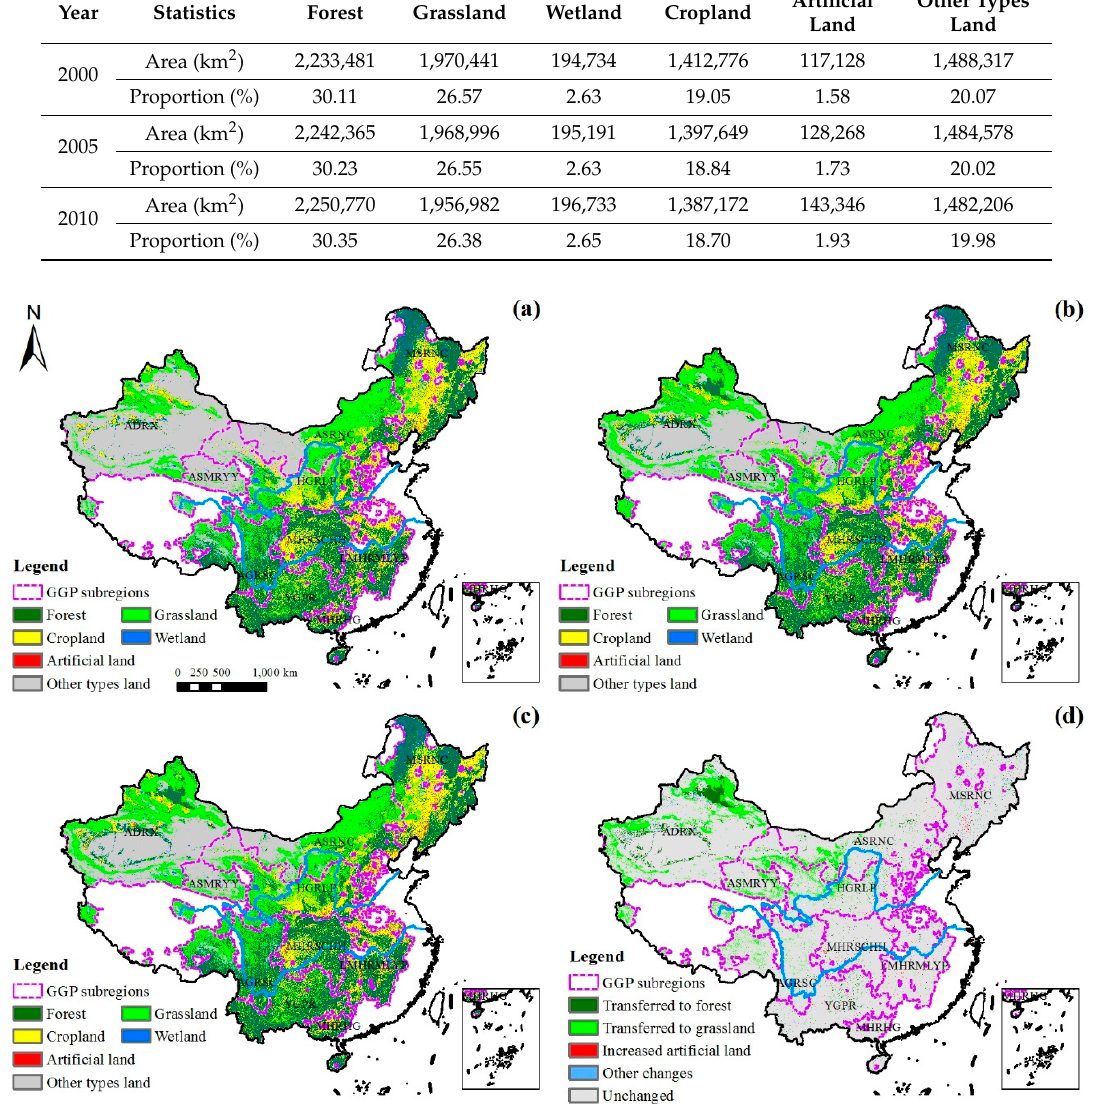
Figure 3. Spatial pattern of ecosystem distribution and transformation in the Grain for Green Program (GGP) area. ( a – c ) are the ecosystem distributions in 2010, 2005, and 2010, respectively; ( d ) is the ecosystem transformation from 2000 to 2010.